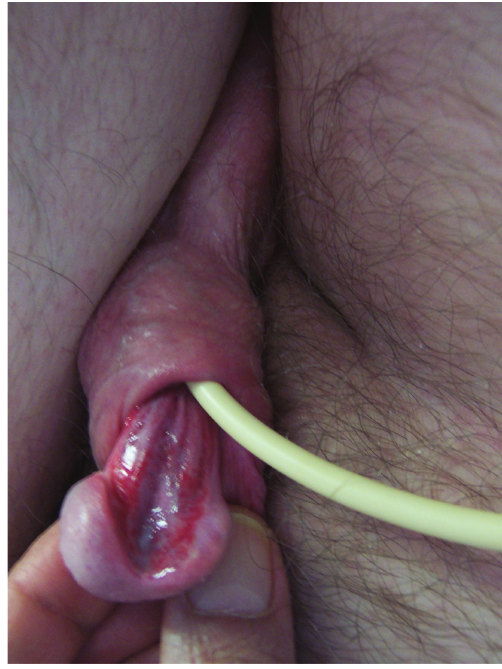
Figure 1: Clinical photograph of penis shows erosion of ventral surface of penis. The Foley catheter has eroded glans penis, penile skin and almost entire penile